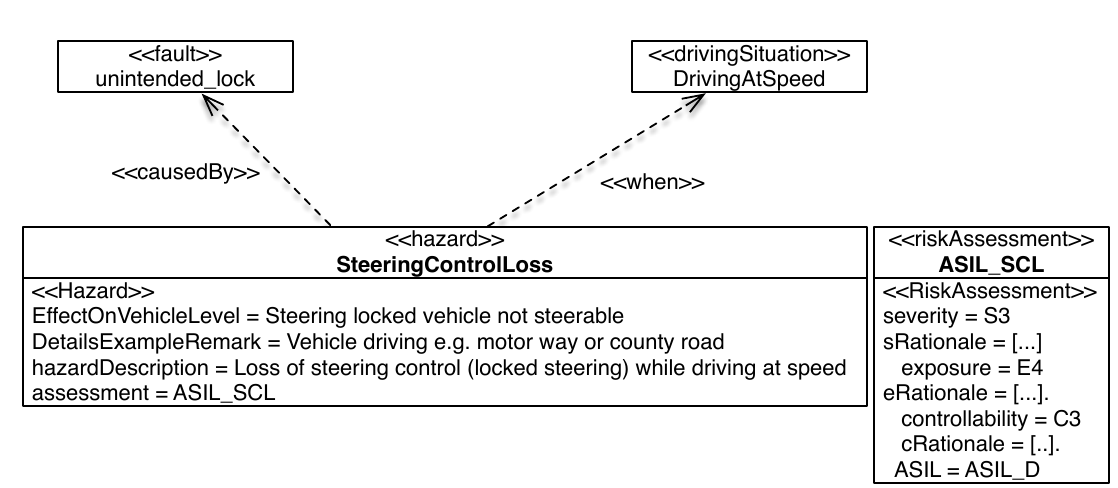
Figure 10. ESCL Hazard Example based on